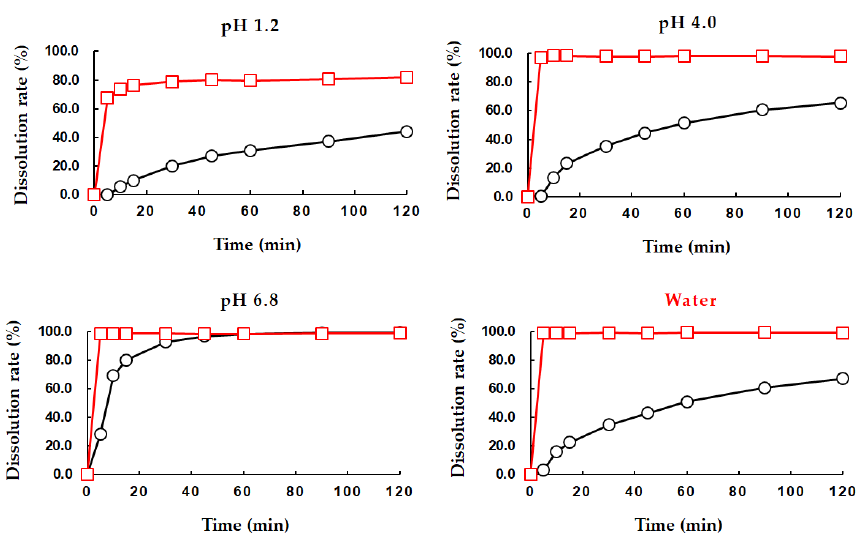
Figure 2. Dissolution profiles of PEL powder (black) and PEL-T powder (red) in the paddle appa- ratus at 50 rpm in 900 mL of buffer media at pH 1.2, 4.0, 6.8, and water ( n =